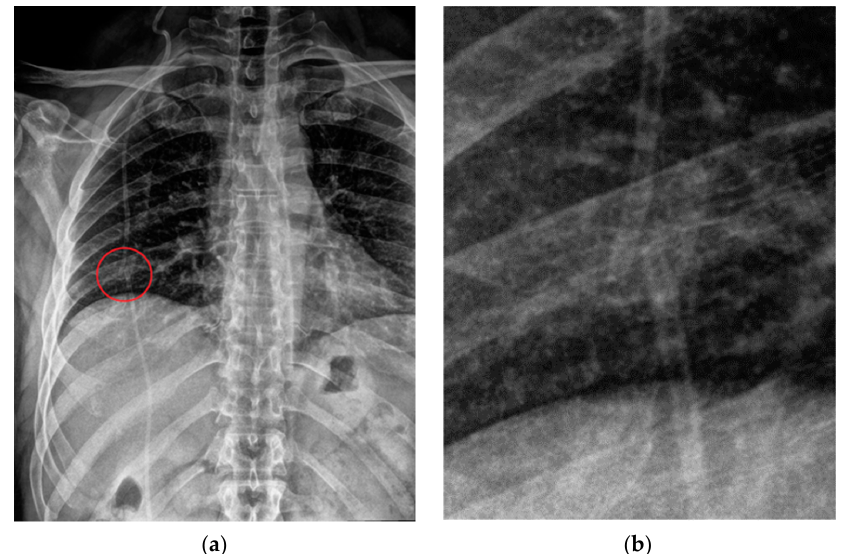
Figure 33. Rupture of a VP shunt (red circle) visible on the PA view of a CXR ( a ), magnified in the second image ( b ).